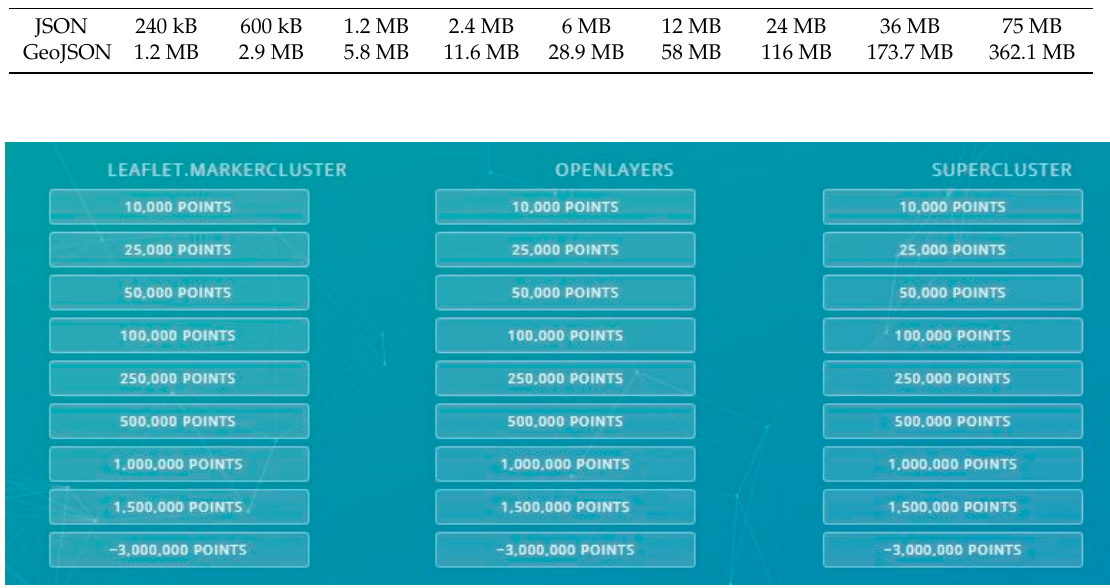
Table 1. Number of records and sizes of datasets.